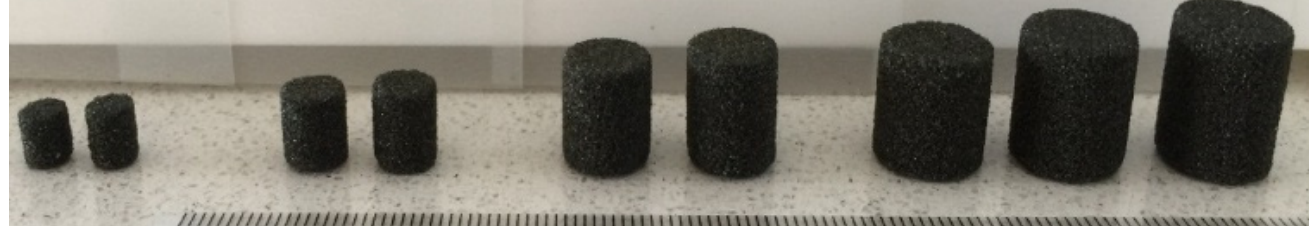
Figure 3. Pictures of 3D-printed cylinders [30].